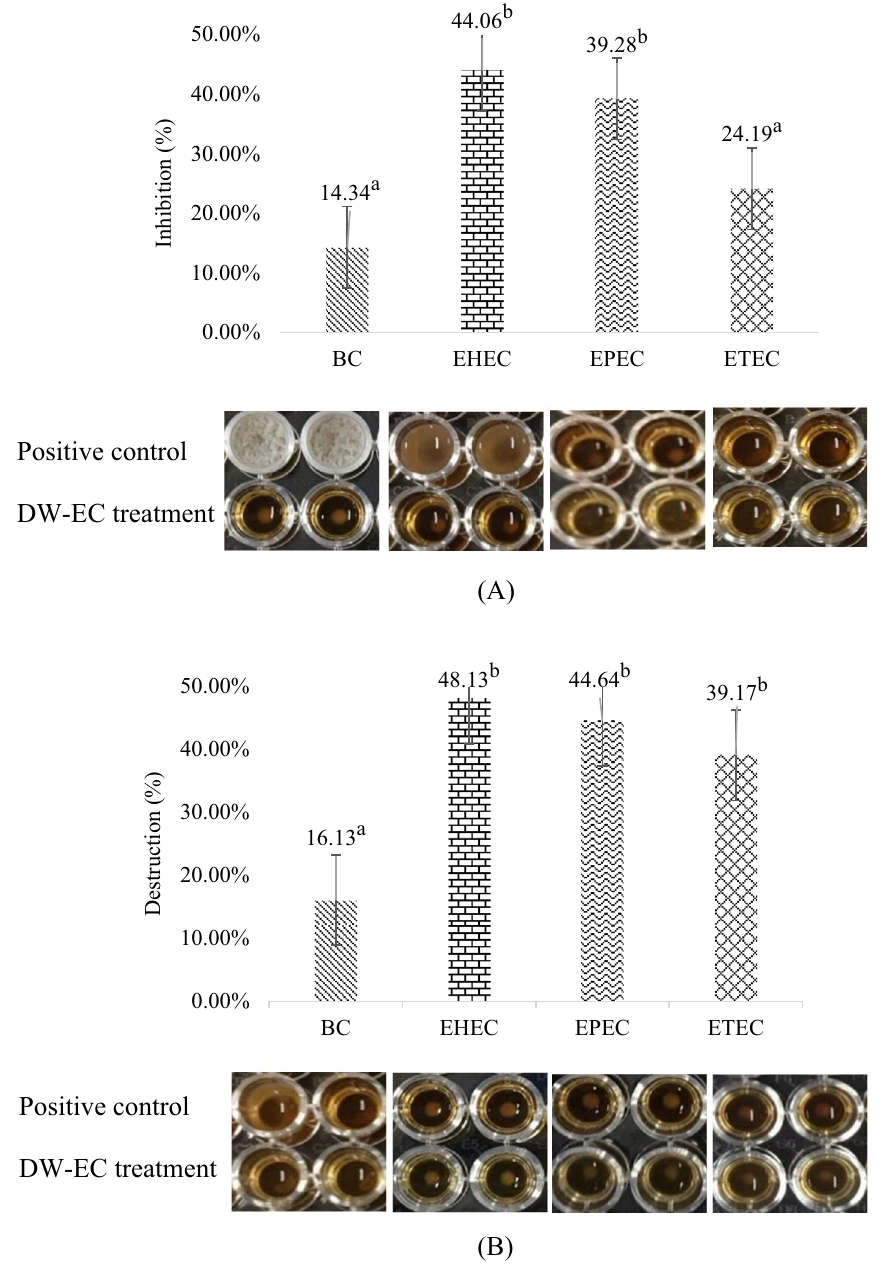
Figure 1. Application of bacteriophage DW-EC against pathogenic bacteria on polystyrene: ( A ) inhibition and ( B ) destruction activity. Different letters indicate significant different between DW-EC treatment to against several biofilm pathogenic bacteria with P ≤